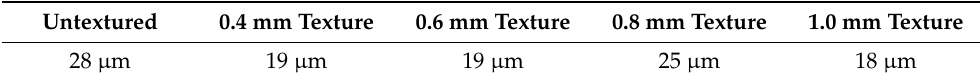
Table 7. Maximum wear depth of disc test piece at 22.5